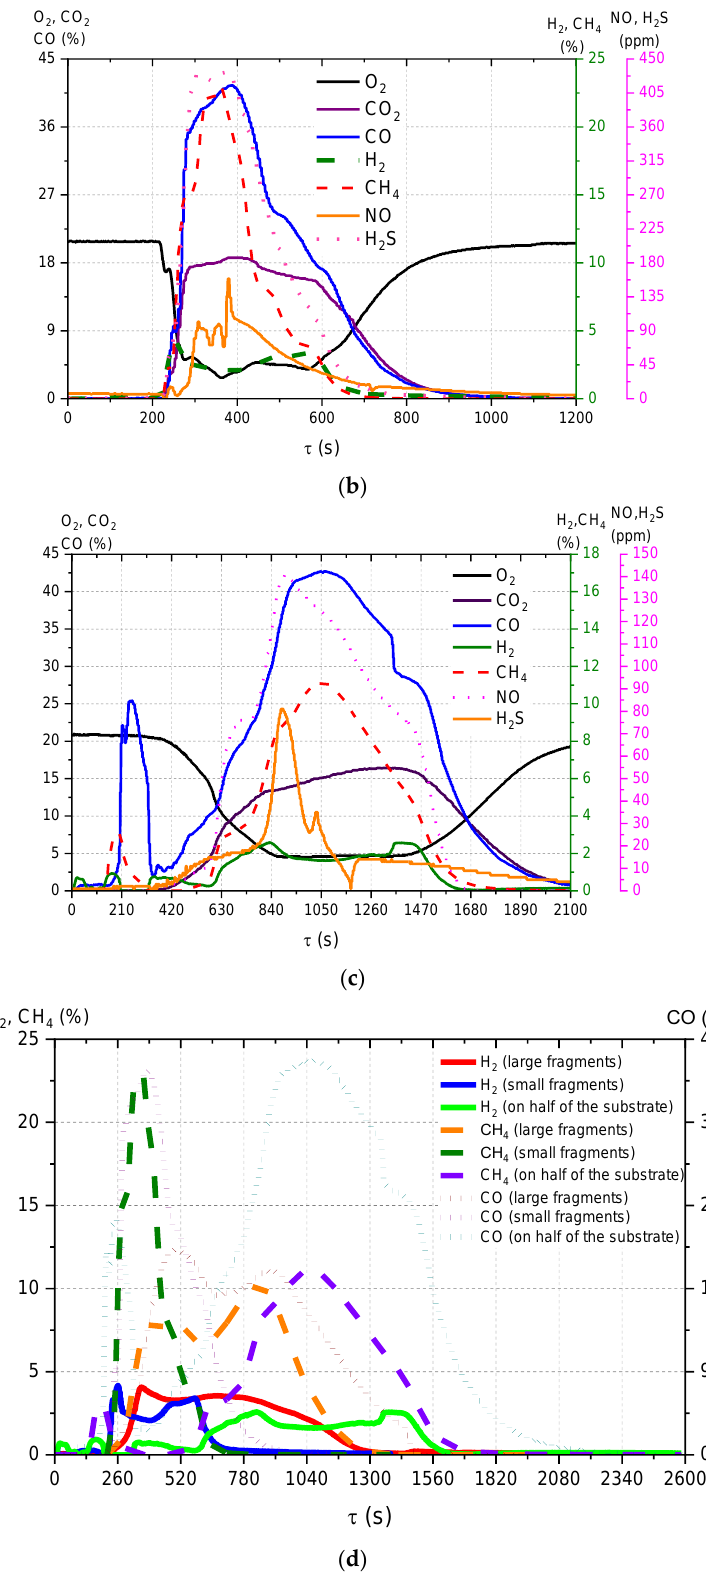
Figure 8. Trends of the concentrations of gas mixture components when varying the distribution of fuel fragments in the crucible: as a set of large fragments ( a ); as a set of small fragments ( b ); on a half of the crucible bottom ( c ); comparison of gas concentrations ( d